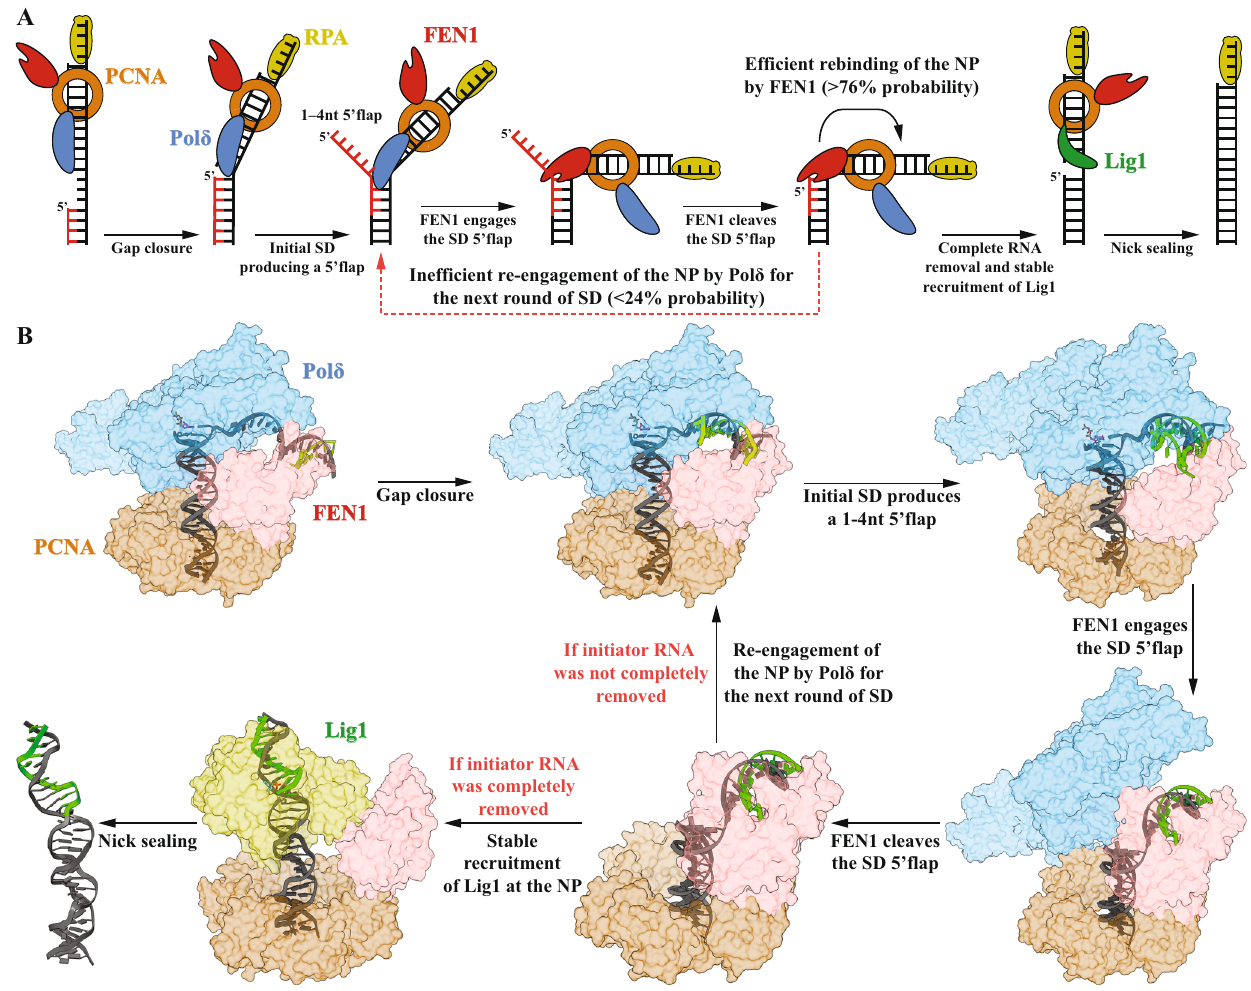
Fig. 7 | Proposed model for human MOF. A Cartoon and B structural model proposed for human MOF and its various intermediary structures and complexes. The structural model was generated based on the structural data presented in refs. 18,